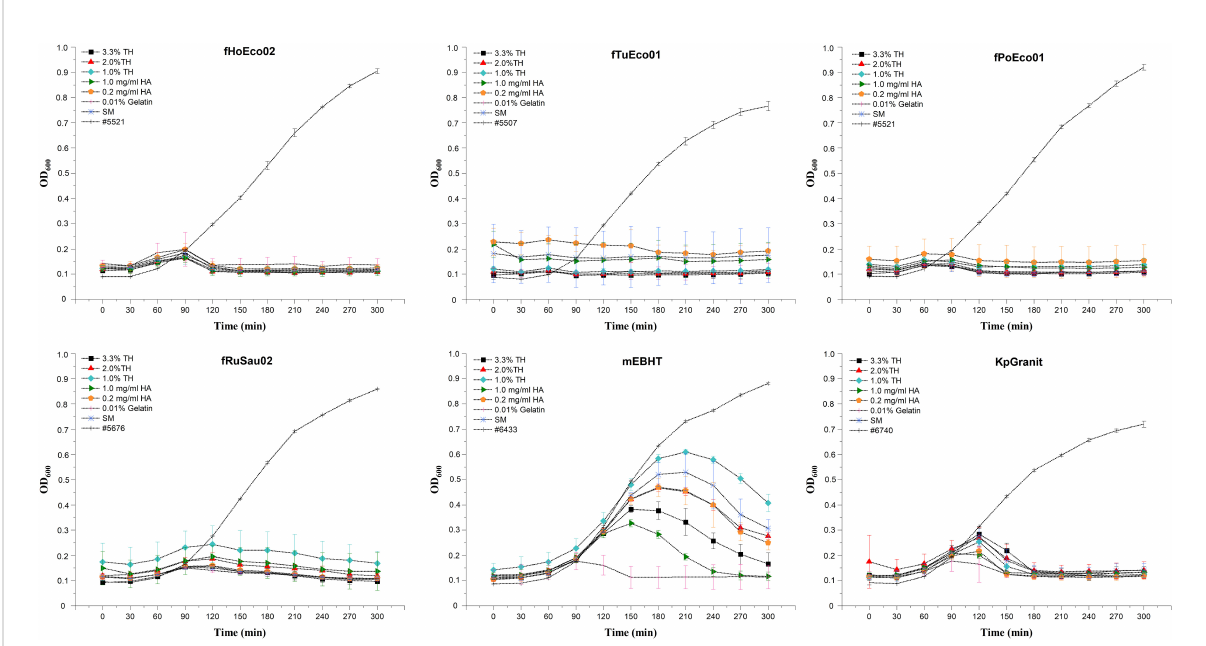
FIGURE 6 Phage susceptibility test performed with phages stored in phage-hydrogel compositions for six months. Phages fHoEco02, fTuEco01, fPoEco01, fRuSau02, mEBHT, and KpGranit were stored with hydrogel and with either 3.3%, 2.0%, or 1.0% trehalose (TH), 0.2 mg/ml or 1.0 mg/ml hyaluronic acid (HA), 0.01% gelatin, or without stabilizer (SM) in 2 ml tubes for six months. Ten µl of phage mixtures were added into the bottom of microtiter plate wells and 200 µl of diluted overnight bacterial culture was added into the wells. Bacterial growth was followed by measuring optical density at 600 nm in 30-minute intervals for fi ve hours. All measurements were performed in triplicate, and mean and SD values are indicated. Bacterial growth in lysogeny broth without phages served as a